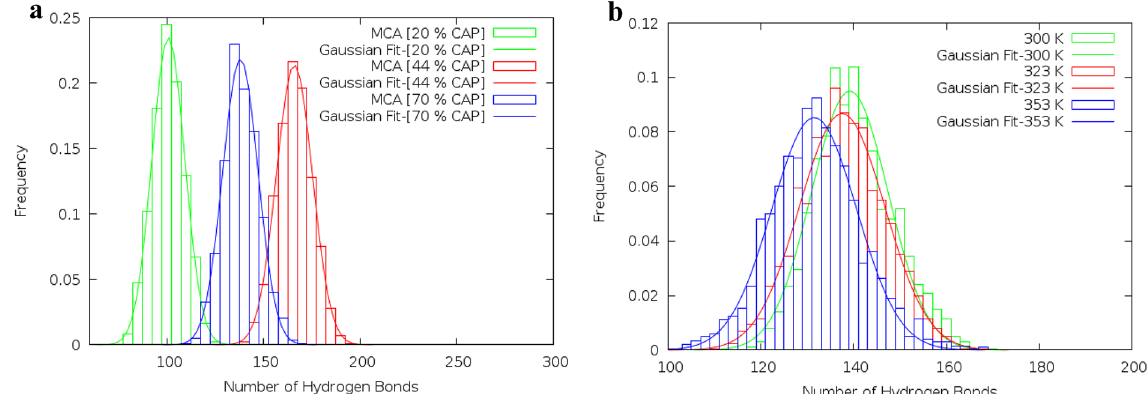
Figure 5. ( a ) The distribution of the hydrogen bond between menthol and CAP molecules in the binary mixtures with %CAP = 20, 44 and 70 at 323 K, ( b ) The distribution of the hydrogen bond between menthol molecules in the binary mixture with %LUA = 44 at different